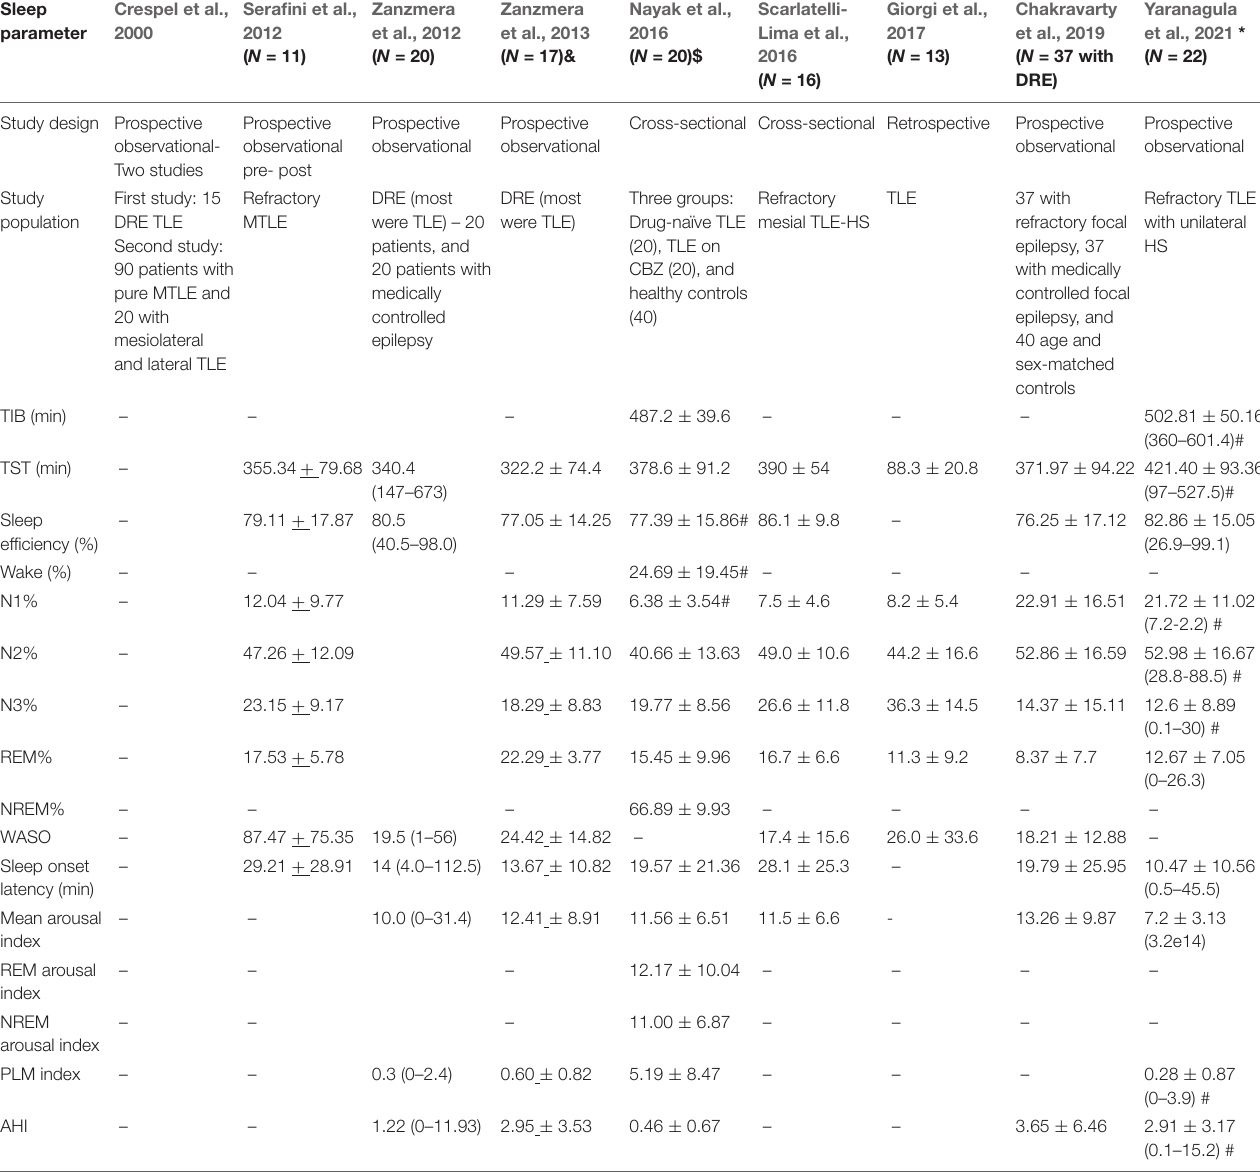
TABLE 4 | Studies assessing sleep macro-architecture in